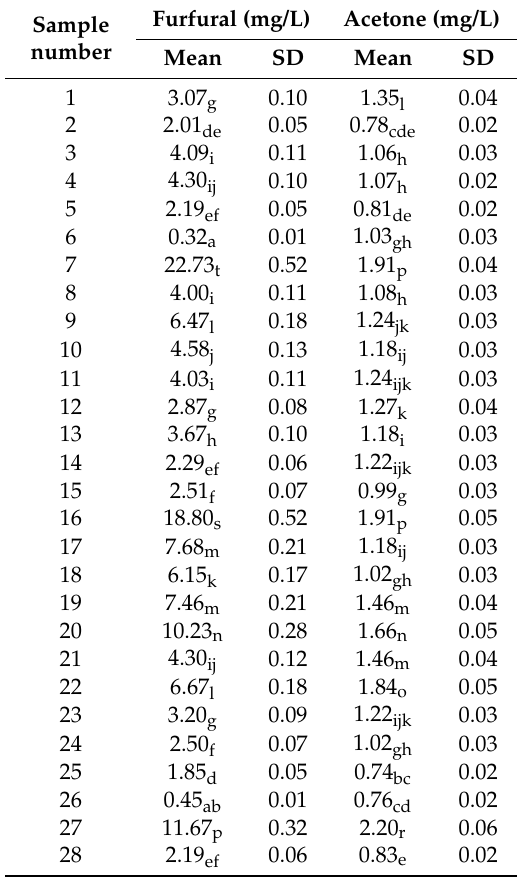
Table 2. Furfural and acetone content in sweet mash samples.